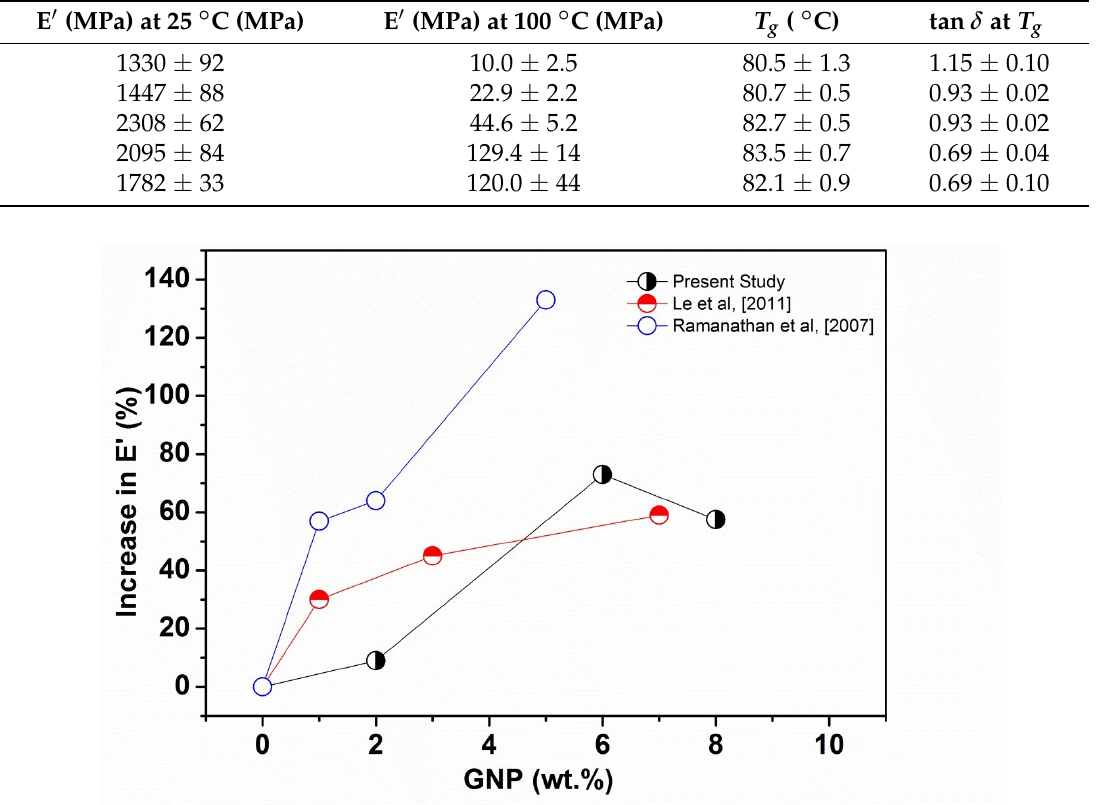
Figure 5. Comparison of E (cid:48) data from reference [35] (PMMA matrix) and [30] (PET matrix) with the present experimental